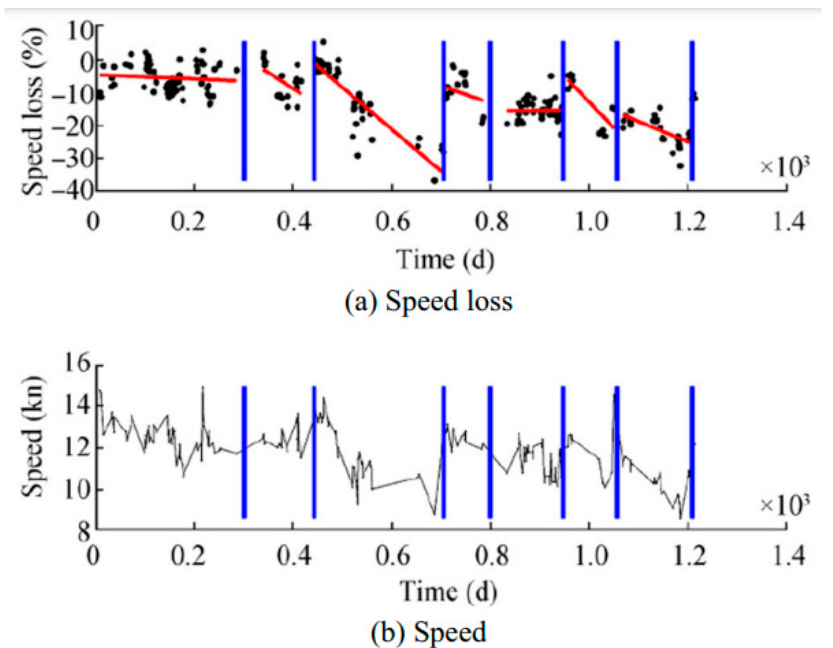
Figure 3. Variation in speed loss and measured speed of a tanker over three years. Vertical blue lines mark the cleaning events. Reproduced from [116], with permission from Chalmers University of Technology,